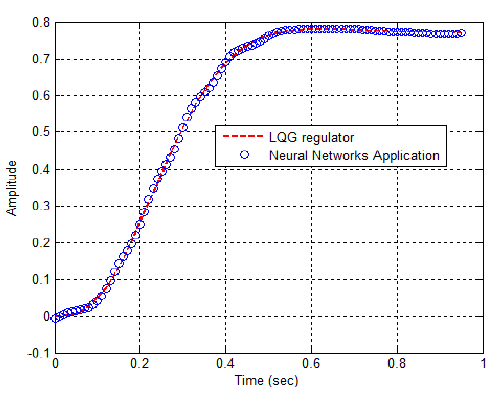
Figure 9. Step Response of the Closed Form